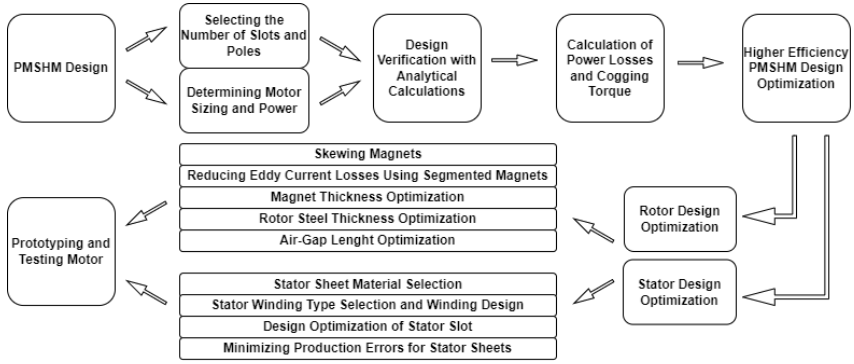
Figure 1. PMSHM design optimization